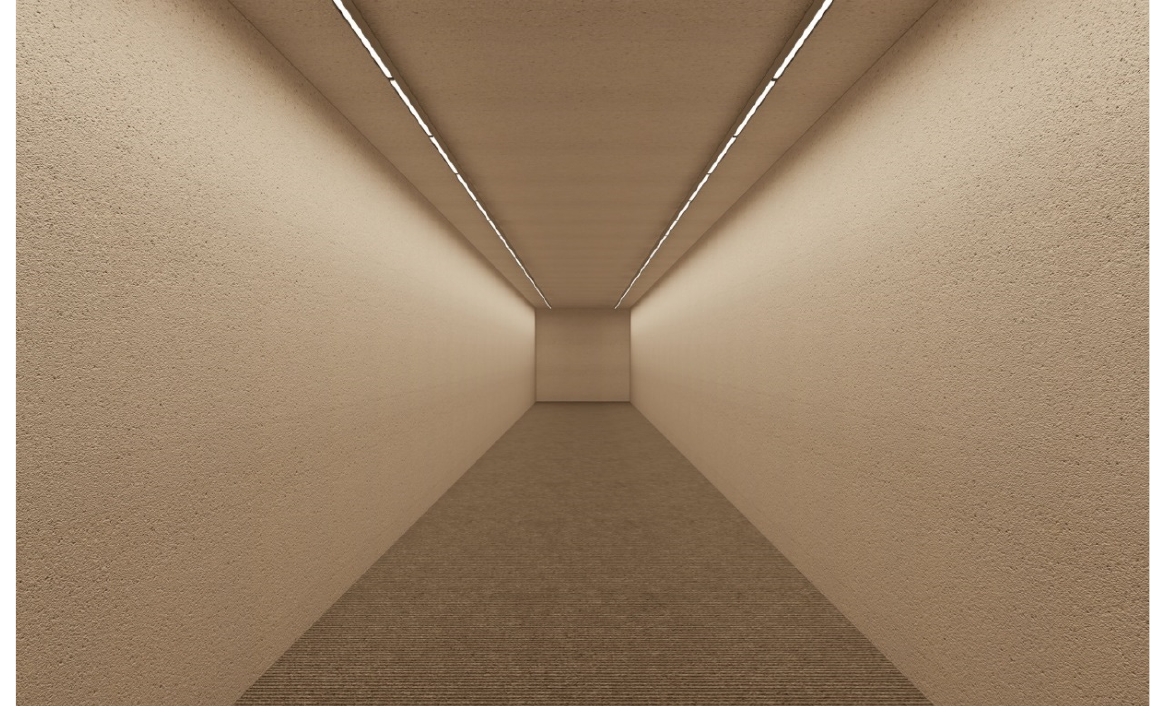
Figure 8. Computer simulation of corridor lighting for variant 5.